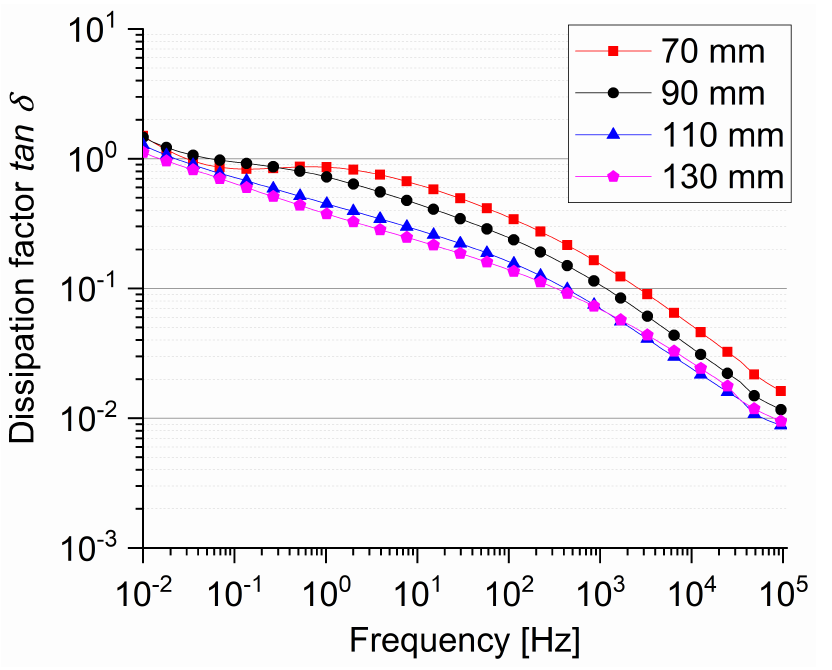
Figure 7. Dissipation factor of Al 2 O 3 coatings as a function of